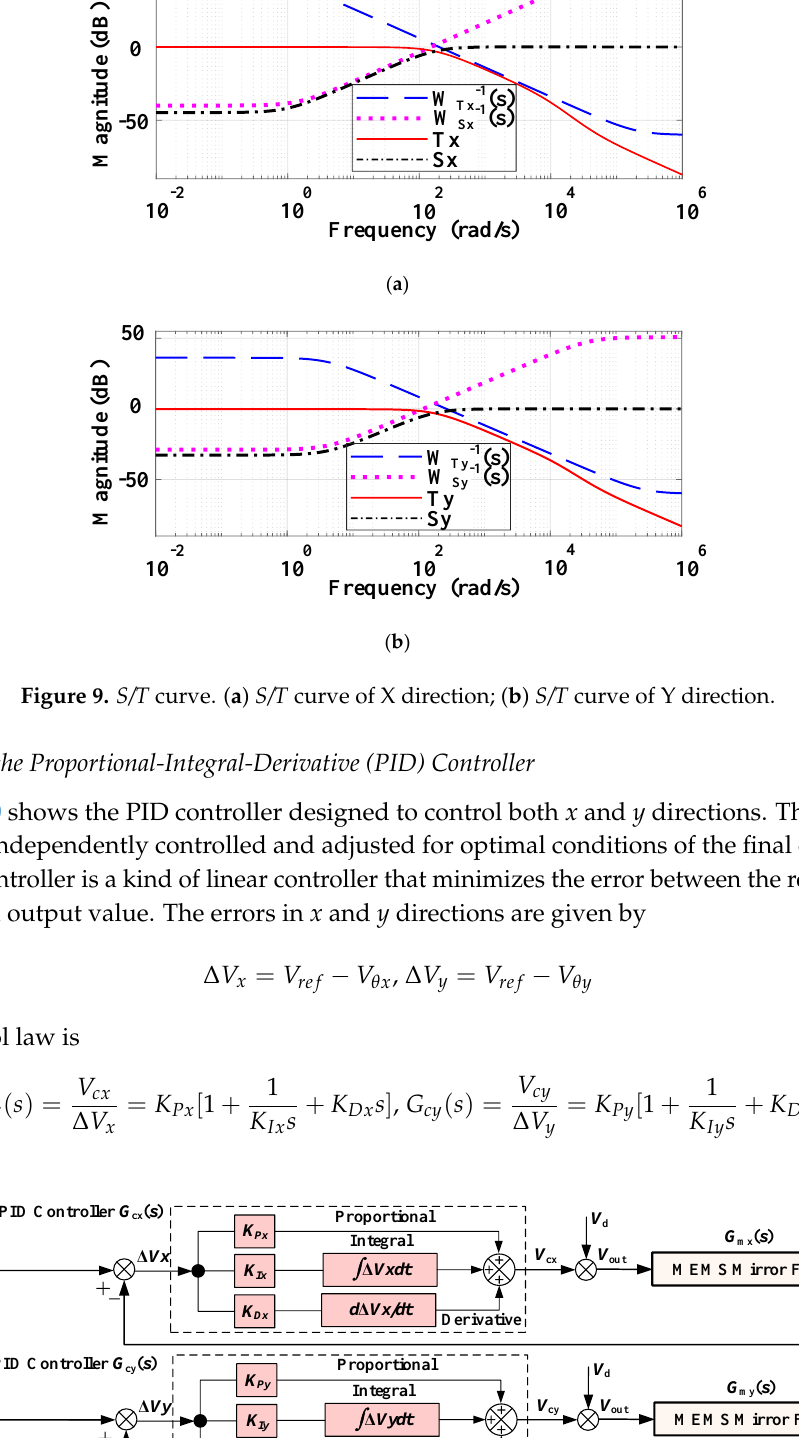
Figure 10. The block diagram of the proposed proportional-integral-derivative (PID) controller.